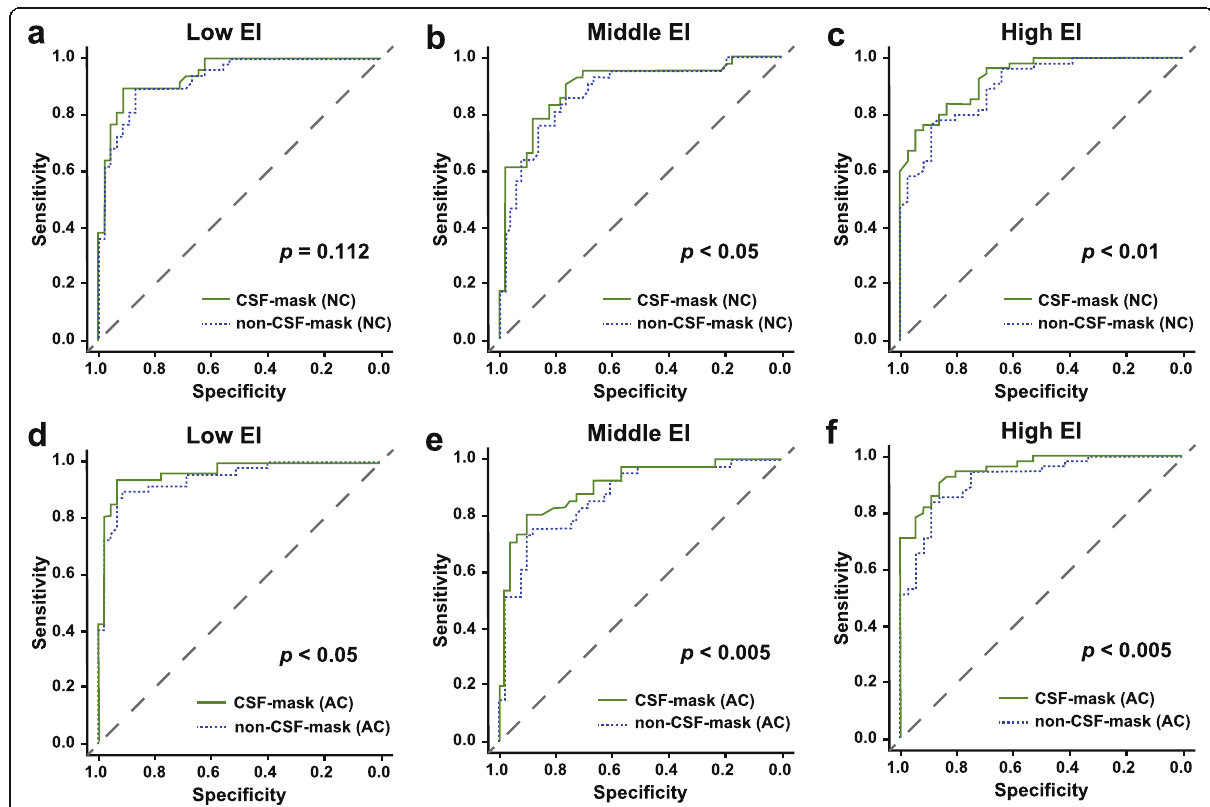
Fig. 6 ROC analyses of the SBRs with and without the CSF-mask algorithm in the low, middle, and high EI groups. a The AUCs for the SBRs with and without the CSF-mask algorithm were 0.942 (95% CI 0.898 – 0.986) and 0.927 (95% CI 0.877 – 0.978), respectively, in the low EI group (NC). b The AUCs for the SBRs with and without the CSF-mask algorithm were 0.894 (95% CI 0.825 – 0.963) and 0.872 (95% CI 0.798 – 0.947), respectively, in the middle EI group (NC). c The AUCs for the SBRs with and without the CSF-mask algorithm were 0.931 (95% CI 0.883 – 0.978) and 0.900 (95% CI 0.840 – 0.961), respectively, in the high EI group (NC). d The AUCs for the SBRs with and without the CSF-mask algorithm were 0.961 (95% CI 0.924 – 0.998) and 0.942 (95% CI 0.895 – 0.988), respectively, in the low EI group (AC). e The AUCs for the SBRs with and without the CSF-mask